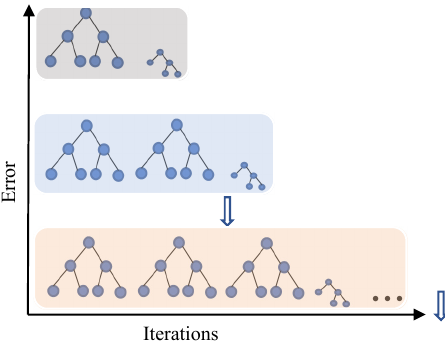
Figure A3. The architecture of EXtreme Gradient Boosting machines.